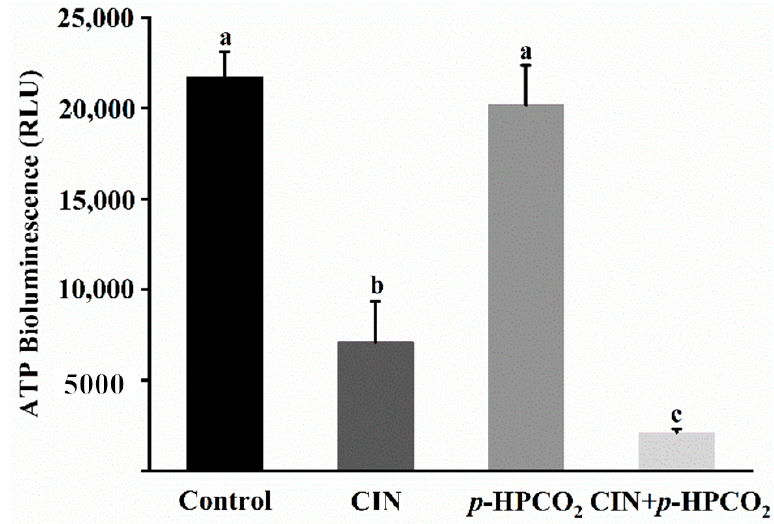
Figure 9. Intracellular ATP content in Saccharomyces cerevisiae treated with individual and combined cinnamon oil (CIN) (0.02%) and petit -high pressure CO 2 ( p -HPCO 2 ) (1.3 MPa) for 2 h at 25 °C. Different letters above bars mean significant differences ( p < 0.05).